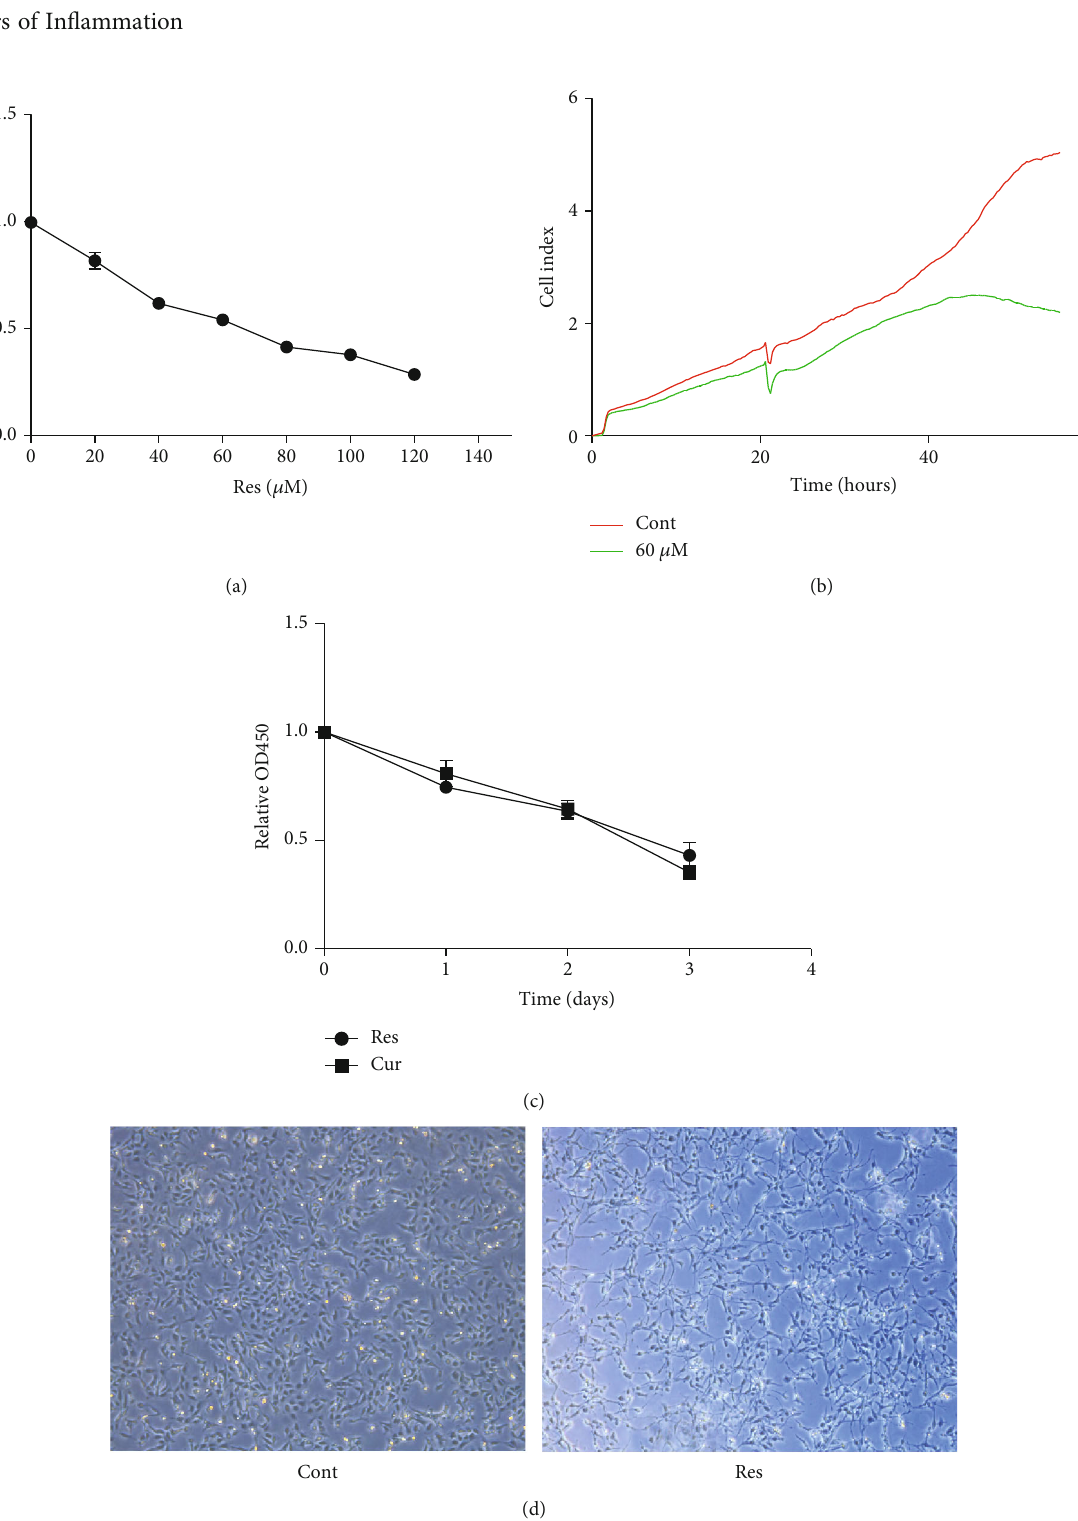
Figure 2: E ff ect of Res on the proliferation of HSCs. (a) Cell proliferation after treatment with di ff erent concentrations of Res determined using the CCK-8 assay. (b) RTCA assay. (c) CCK-8 assay performed to detect cell proliferation in cells treated with Res or Cur. (d) Cell morphology. Magni fi cation: ×